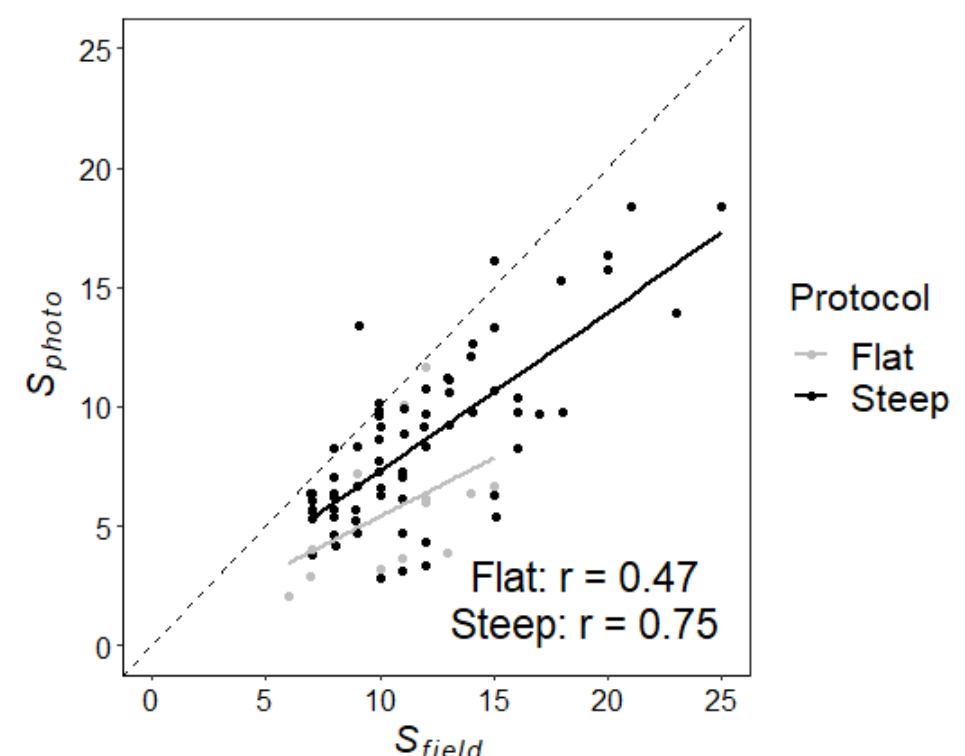
Figure 4. Relationship between species richness of field observations (S field ) and Photogrid surveys (S photo ) for Flat and Steep protocols. Data are from 2018 field surveys including 69 steep (shown in black) and 14 flat plots (shown in grey). The dashed line is the one-to-one line. Results of a linear mixed-effects regression showed a significant effect of S field (F 1,79 = 95.55, p < 0.0001) and protocol (F 1,79 = 7.91, p = 0.006) on S photo , with no significant interaction (F 1,79 = 0.47, p > 0.05). Pearson correlation coefficients between S photo and S field are shown.